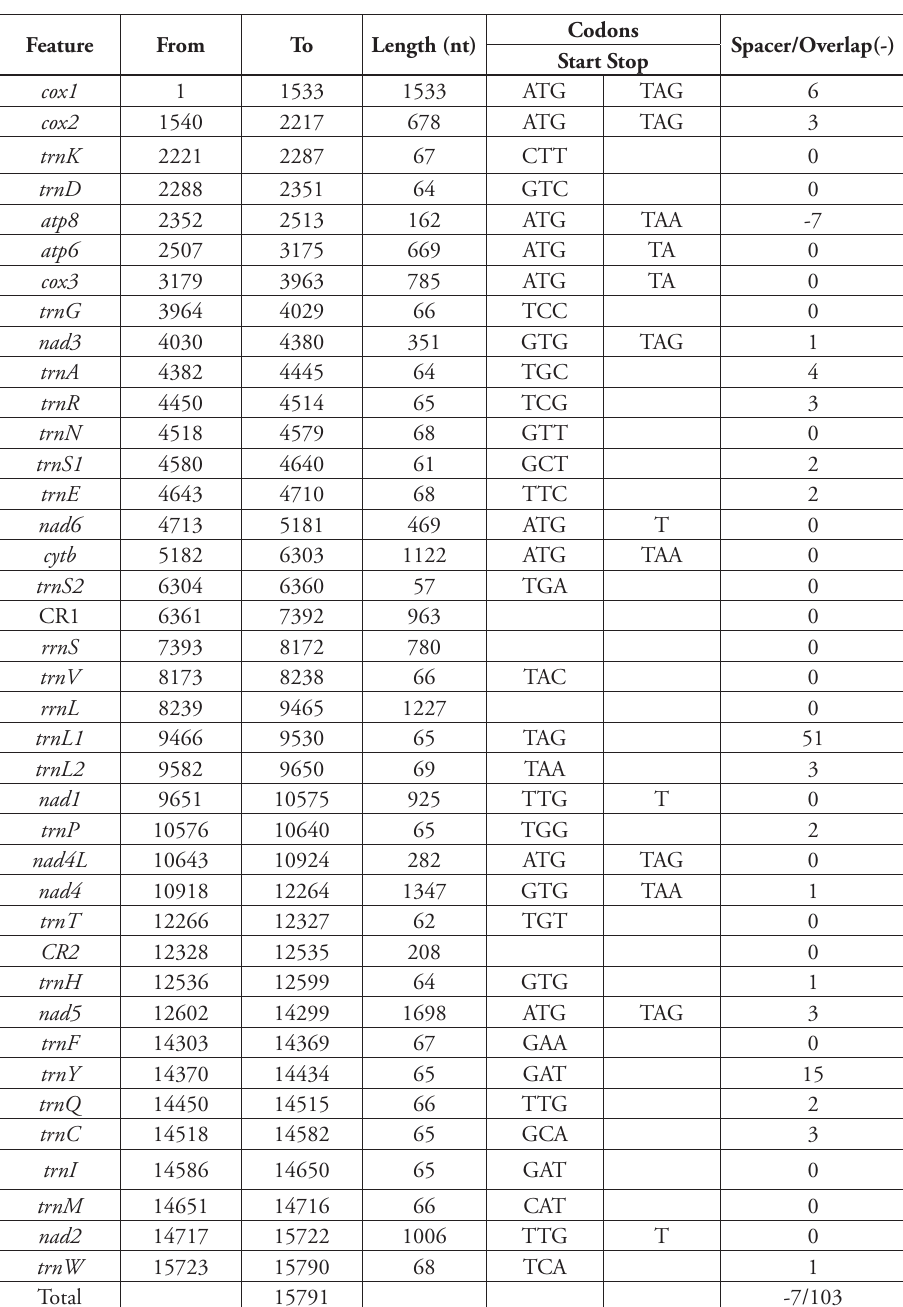
Table 2. Organization of the mitochondrial genome of Xystodesmus sp.